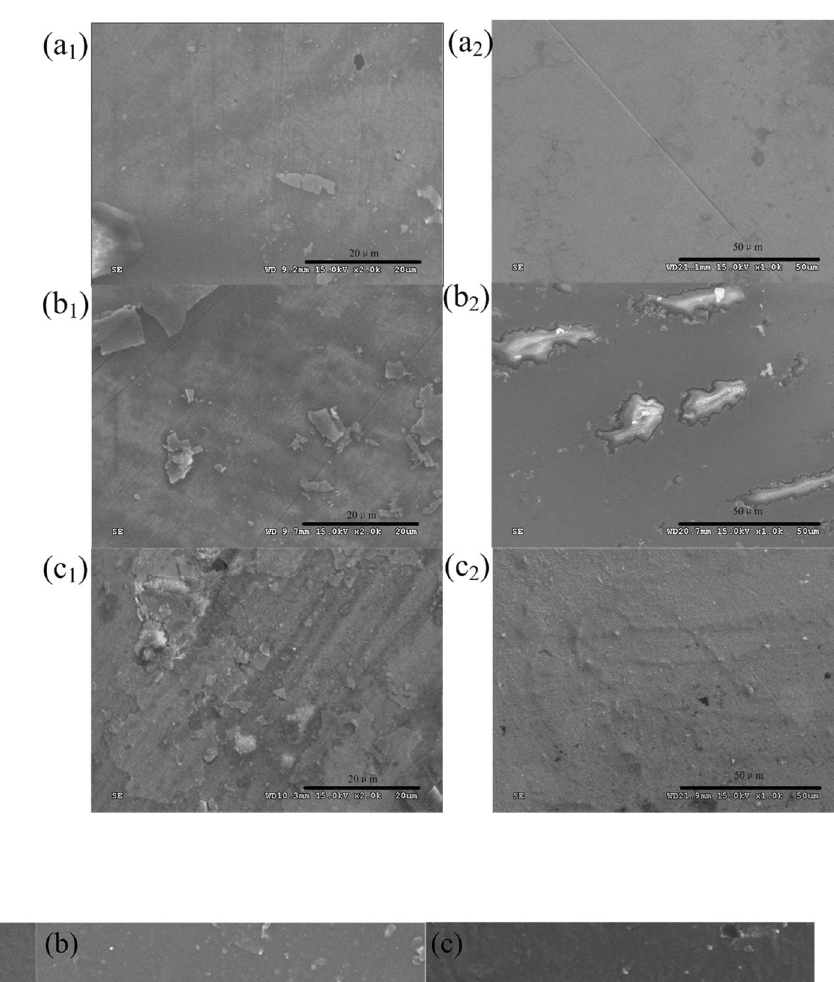
Fig. 7 SEM of different pins. a1